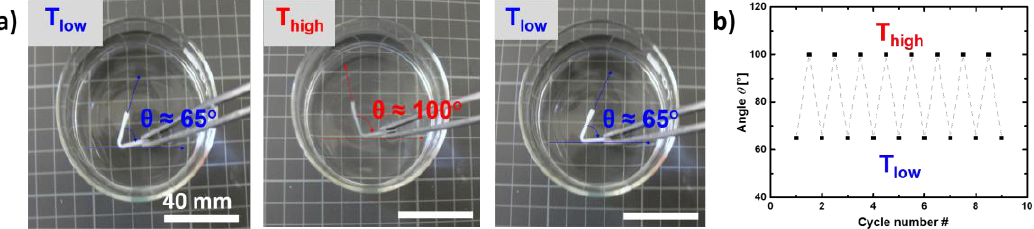
Figure 3. ( a ) Comparison of image series at different temperatures indicating the angle change at T low and T high for cPCL 95 -L 05 ; ( b ) Multiple cycle experiment for the angular change between T low and T high for PCL 95 -L 05 .